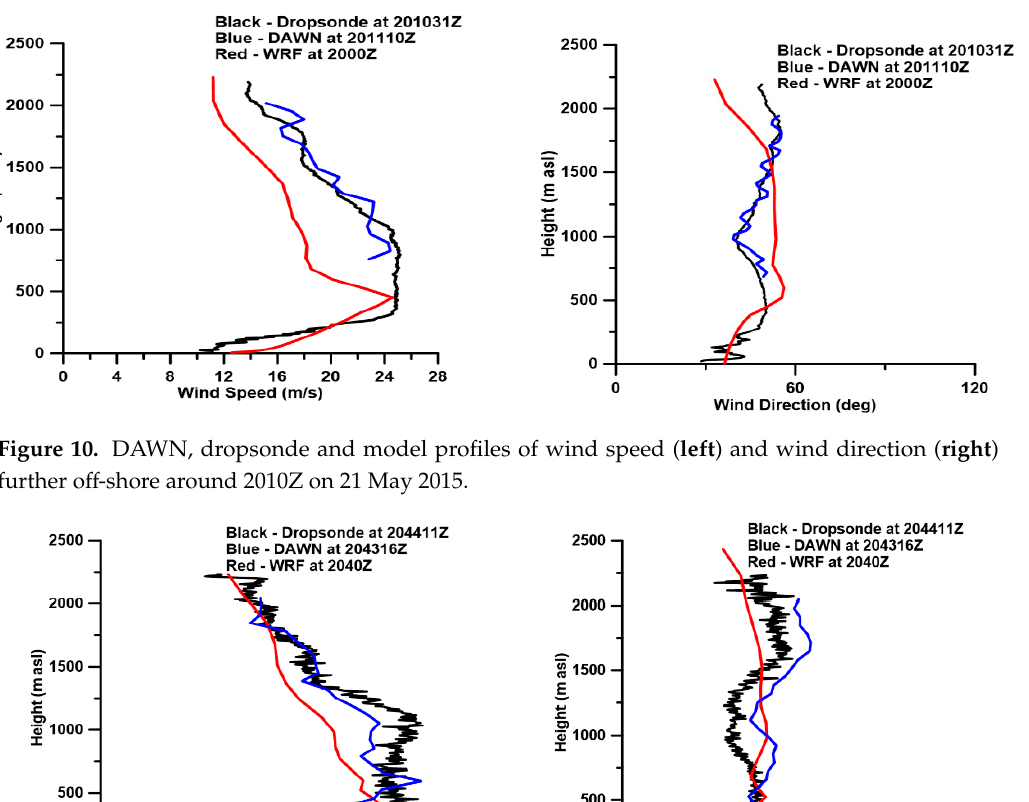
Figure 9. DAWN, dropsonde and model profiles of wind speed ( left ) and wind direction ( right ) closer to the coast around 2100Z on 21 May 2015.